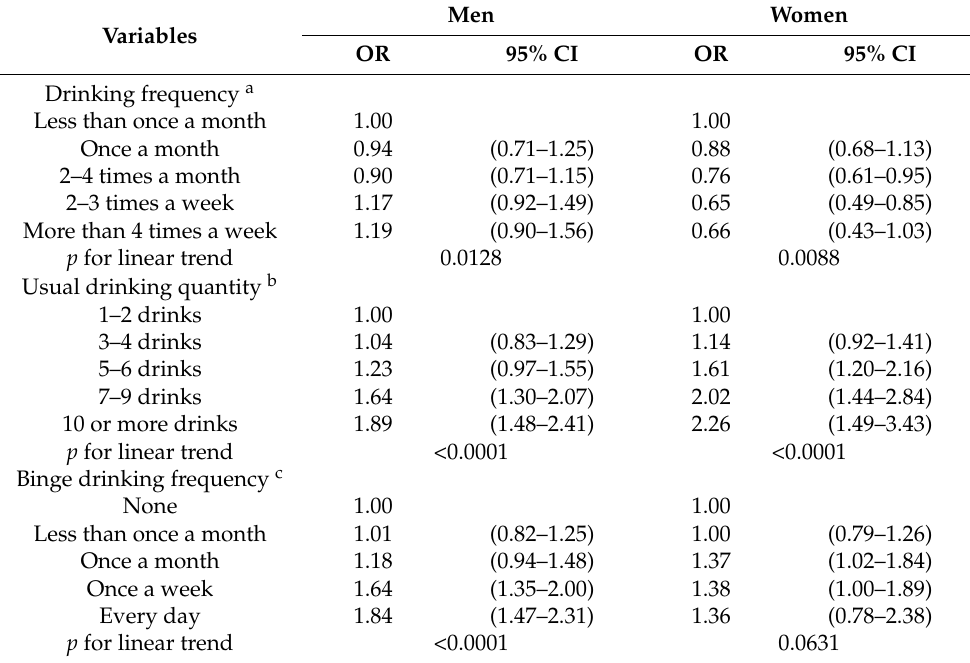
Table 2. Associations between alcohol drinking patterns and metabolic